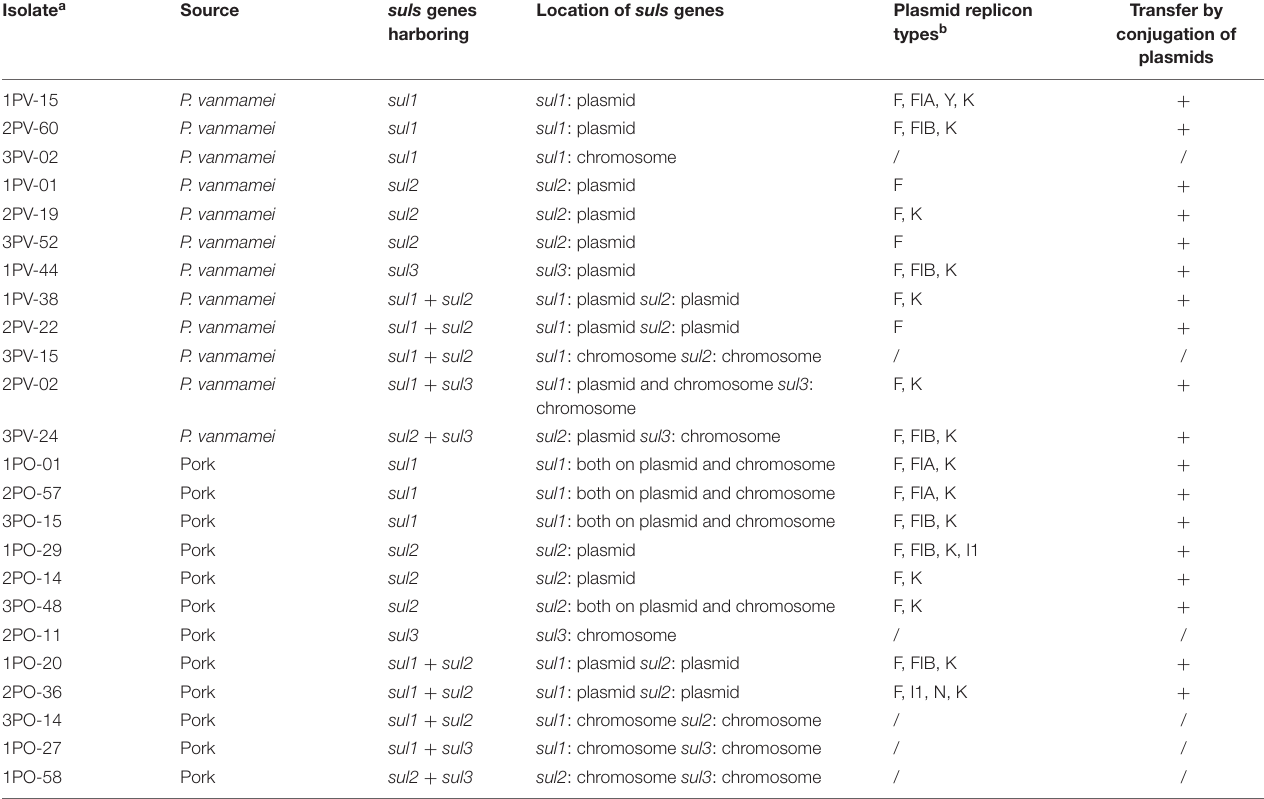
TABLE 3 | Characteristics of 24 sul -positive Escherichia coli isolates. Isolate a